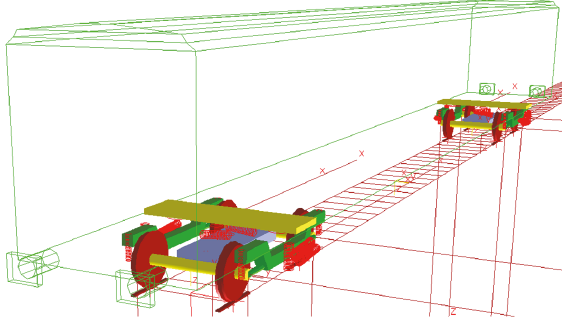
Figure 11: Multibody dynamics model of high-speed